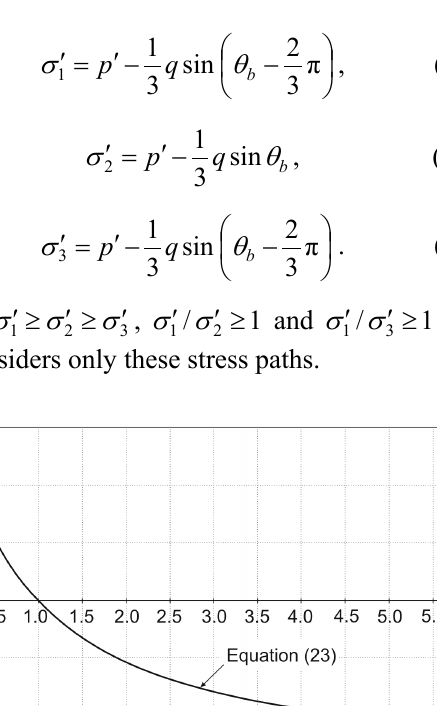
(intermediate stress ) b